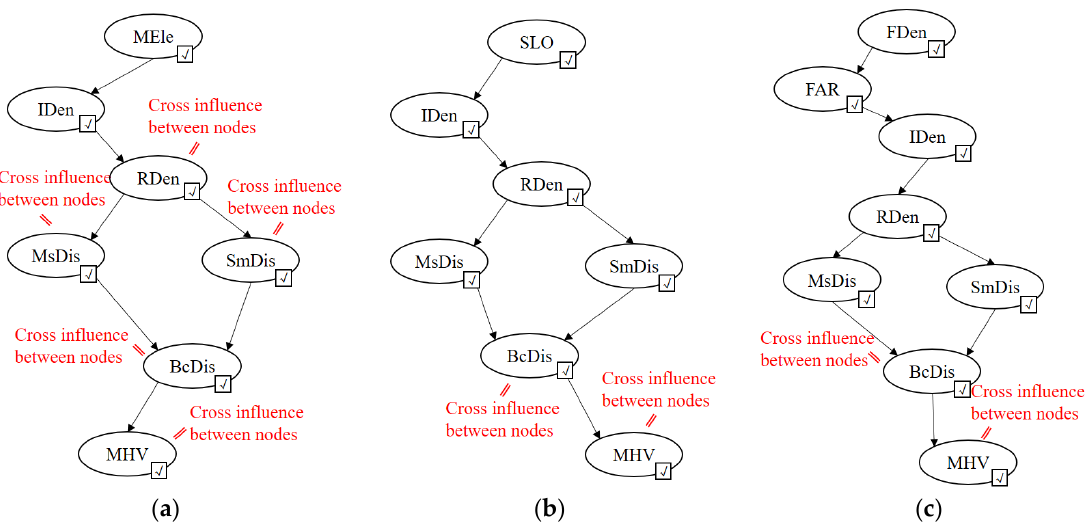
Figure 8. The longest path of the factor combination groups of different root nodes. ( a ) The longest path with MEle as the root node; ( b ) the longest path with SLO as the root node; ( c ) the longest path with FDen as the root node. Table 8. Analysis of factor combination groups.